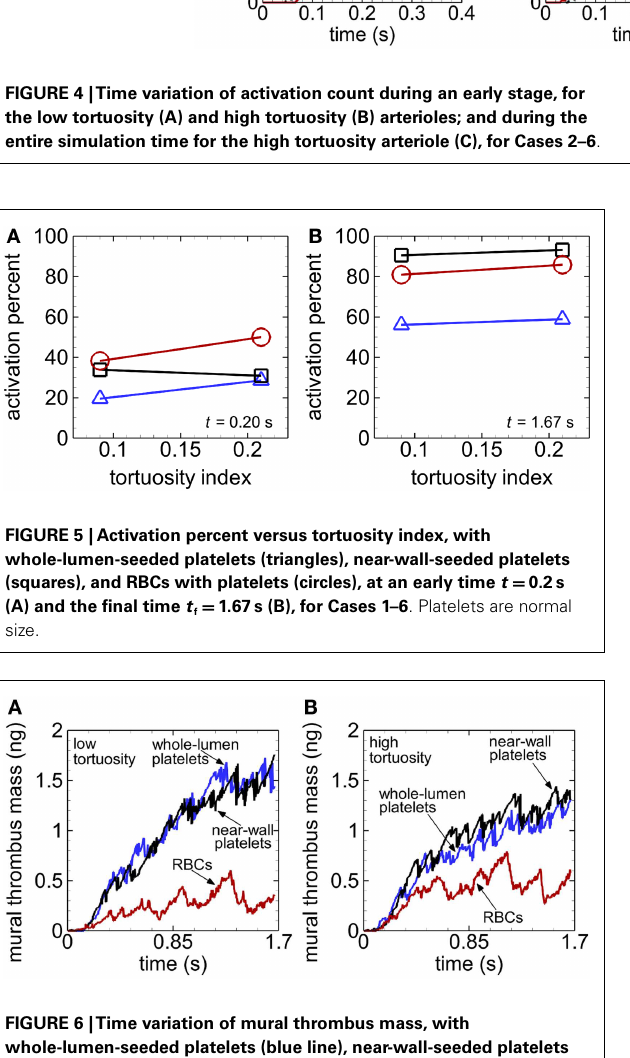
FIGURE 6 |Time variation of mural thrombus mass, with whole-lumen-seeded platelets (blue line), near-wall-seeded platelets (black line), and RBCs with platelets (red line), for the low tortuosity arteriole (A) and high tortuosity arteriole (B), for Cases 1–6 . Platelets are normal size.